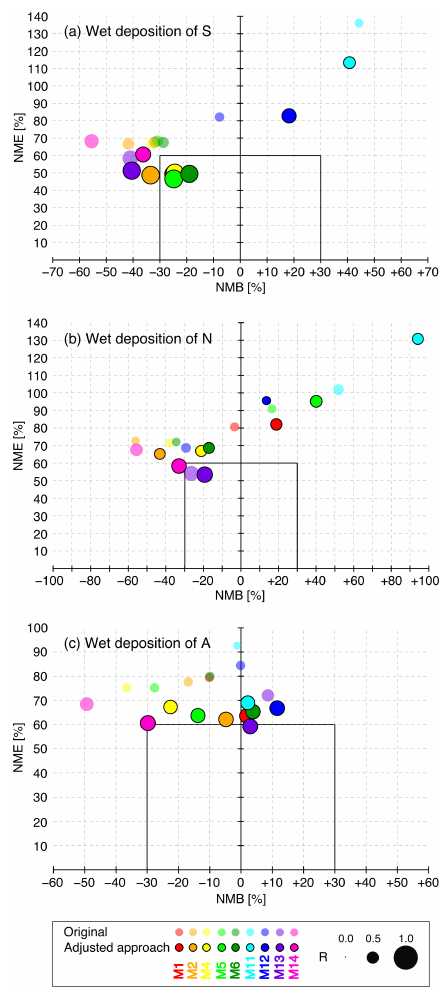
Figure 14. Soccer-goal plot of NMB ( x axis) and NME ( y axis) for the original wet deposition (transparent circles) and precipitation- adjusted wet deposition (solid circles) of (a) S, (b) N, and (c) A. The size of each circle indicates R . Note that the ranges of NMB and NME are different among the three